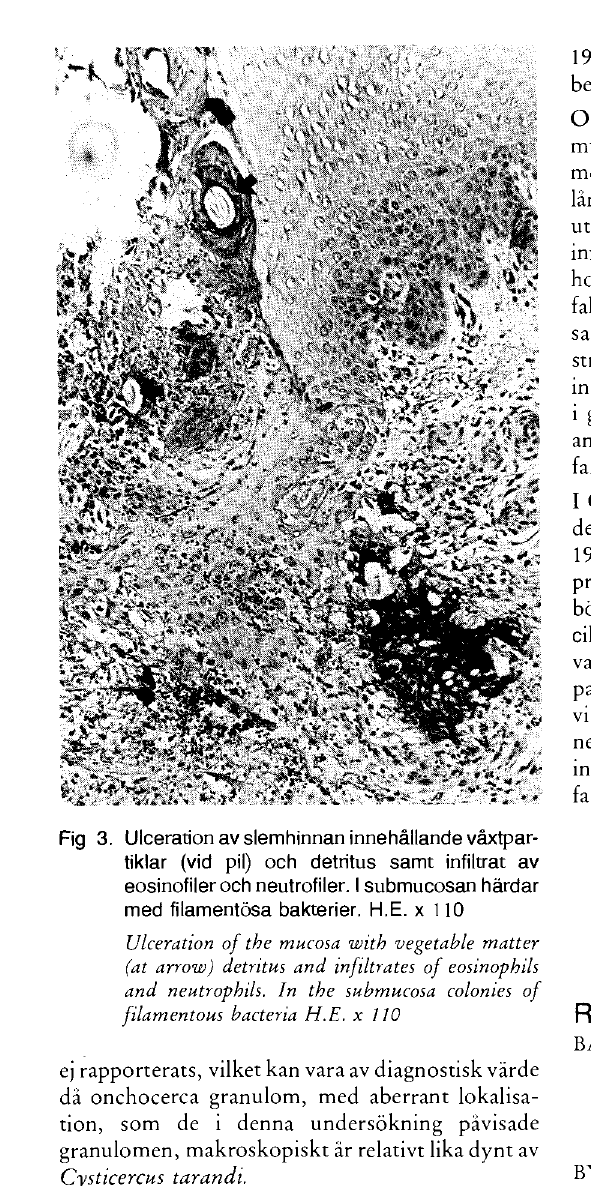
Fig 3. Ulceration av slemhinnan innehållande våxtpar- tiklar (vid pil) och detritus samt infiltrat av eosinofileroch neutrofiler. I submucosan hardår med filamentosa bakterier. H.E. x 1 10 Ulceration of the mucosa with vegetable matter (at arrow) detritus and infiltrates of eosinophils and neutrophils. In the submucosa colonies of filamentous bacteria H.E. x